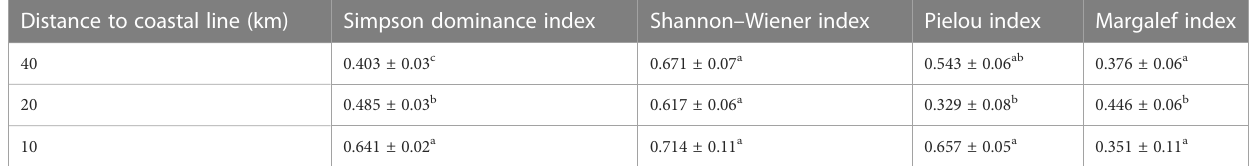
TABLE 3 Species diversity in the investigated Tamarix chinensis plots at the three different distances to coastal line. Distance to coastal line (km)